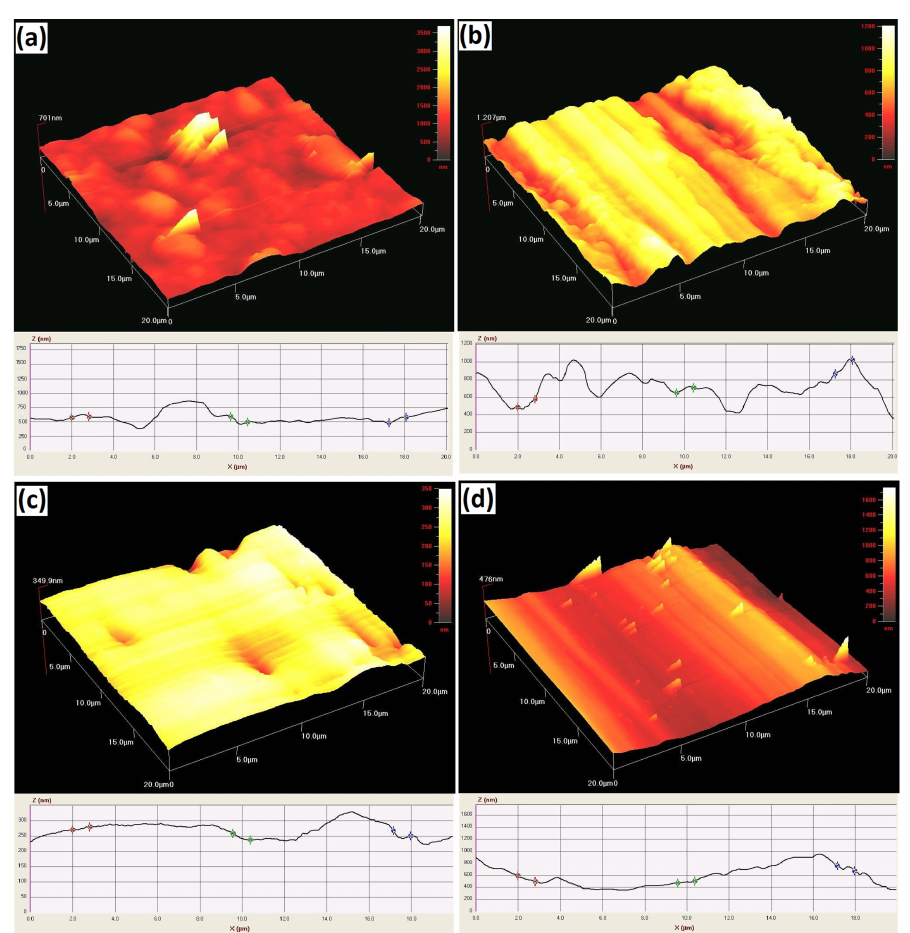
Figure 9. Topographic images of undamaged and wear surfaces on ( a , b ) Al-15Fe 3 O 4 and ( c , d ) Al-15Fe 3 O 4 -30SiC specimens over an area of 20 µ m × 20 µ